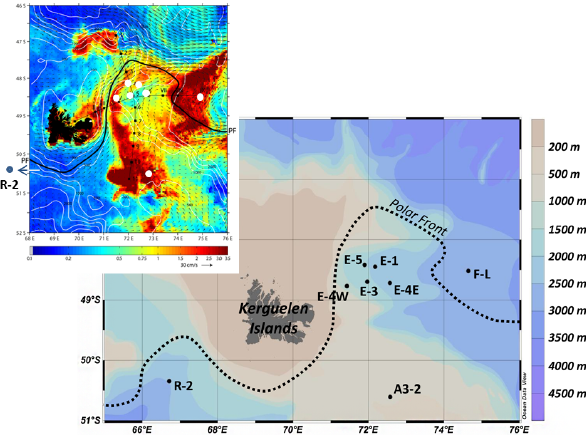
Figure 1. Map of the KEOPS 2 cruise area (Indian sector of the Southern Ocean) showing the location of stations discussed in the study, courtesy of Ivia Closset. Dotted line represents the position of the polar front from Park et al. (2014). The inset picture gives indication about surface chl a (colour scale), surface velocity fields (arrows), and the polar front (PF, black line). Black dots in the inset picture represent KEOPS 2 transect stations which were not consid- ered in this study; stations for which we performed incubations are represented by the white circles: the bloom stations over the Ker- guelen Plateau (E4-W and A3-2) and north of the polar front (F-L) and the meander stations (E stations). The reference HNLC station (R-2) lies outside the area covered by the map (66.69 ◦ E, 50.39 ◦ S). This satellite picture corresponds to the last week of the KEOPS2 cruise. Courtesy of Y. Park and